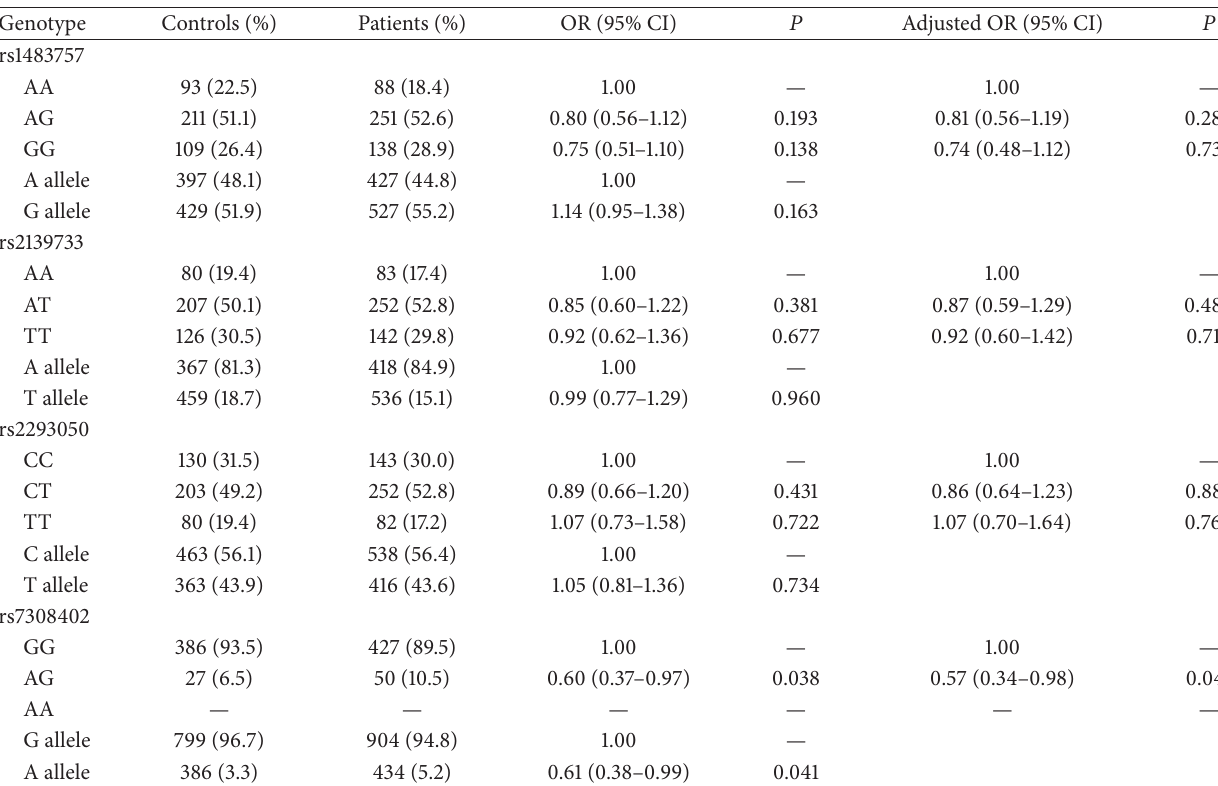
Table 2: Genotype and allele frequency of 4 sites of NOS1 gene n